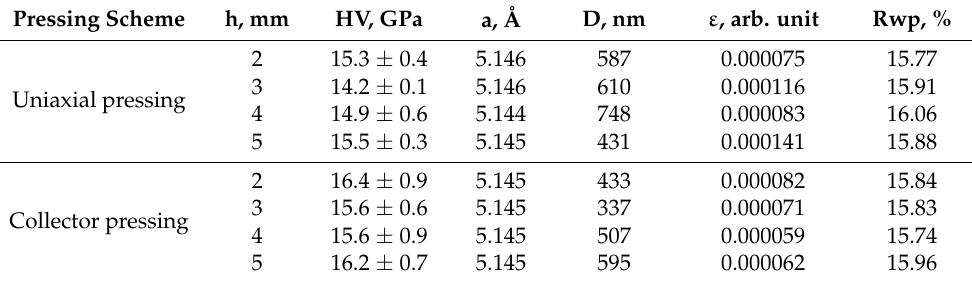
Table 2. Parameters of the crystal structure and microhardness of YSZ ceramics.